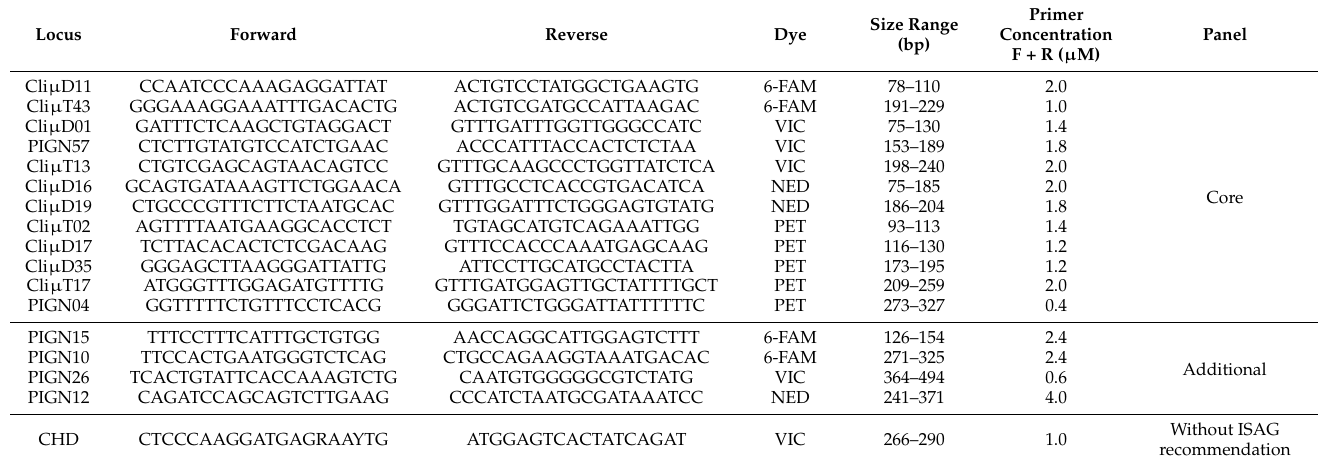
Table 1. Characteristics of 17 microsatellite